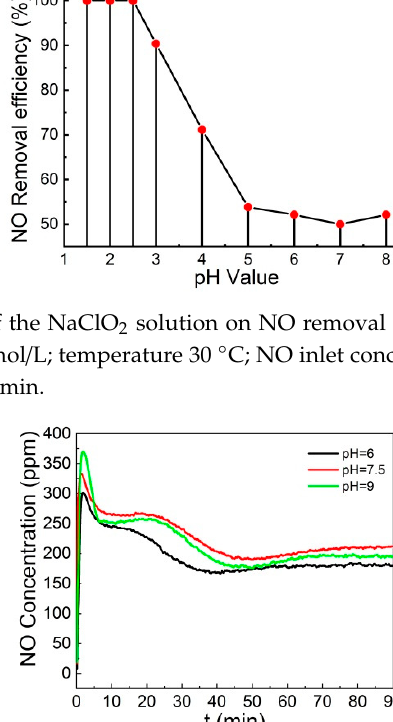
Figure 6. Effect of the initial pH of the NaClO 2 solution on NO removal. Reaction conditions: NaClO 2 concentration 0.008 mol/L; temperature 30 °C; NO inlet concentration 500 ppm; N 2 balance, with a total flow rate of 1.5 L/min.